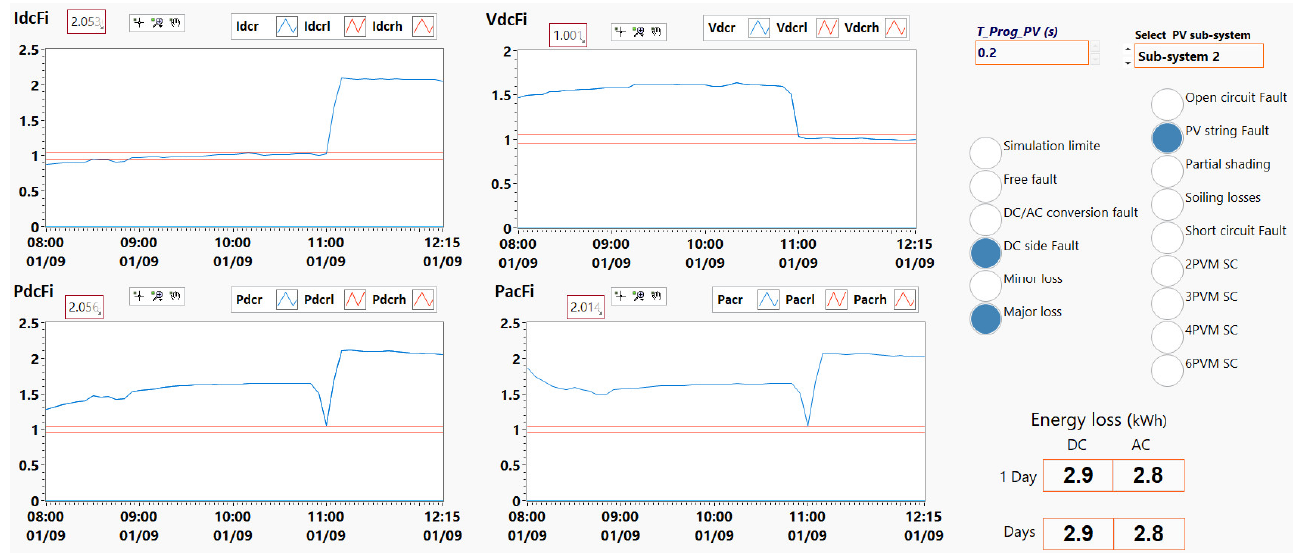
Figure 29. Identification of PV string fault in sub-array